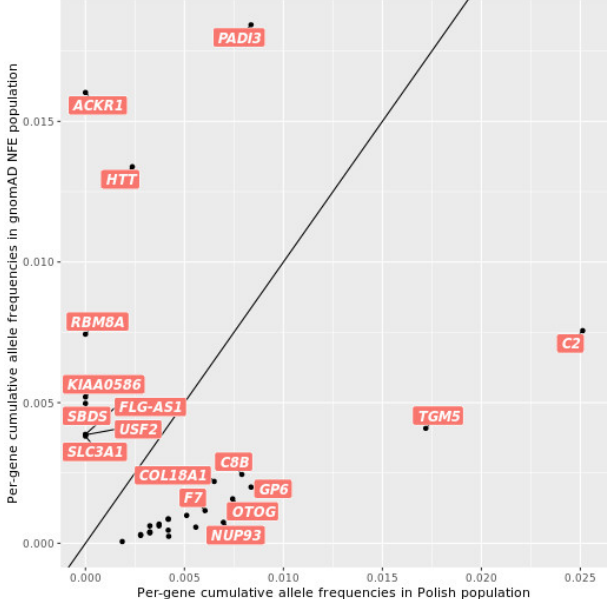
Figure 5. Cumulative allele frequencies of selected ClinVar variants in the 32 AR genes with significant (q-value < 0.05) differences in pathogenic variant burden among POL and gnomAD NFE. Note that for two genes with significant differences, the only variant observed in POL was removed from Clinvar after the release we used. These were HTT (rs754013273; RCV001335909.1) and COL18A1 (rs528991245; RCV001329610.1).